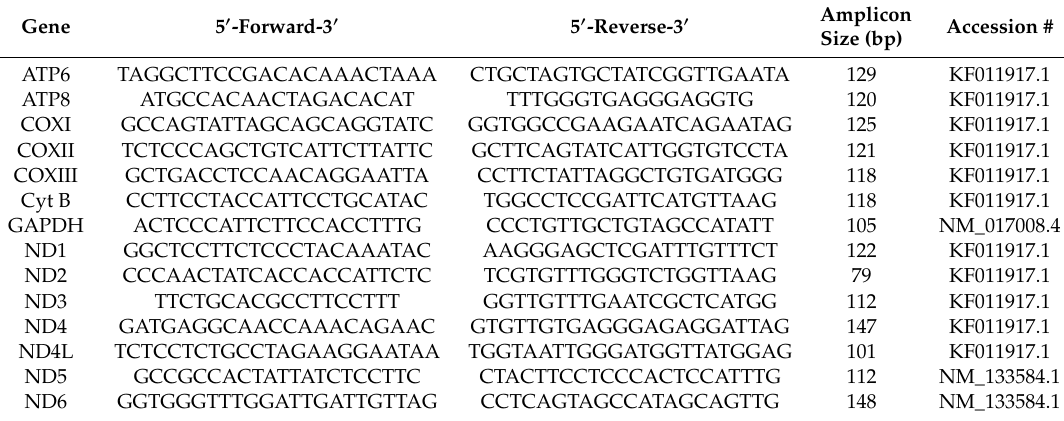
Table 4. Oligonucleotides used for the study of mtDNA copy number and gene